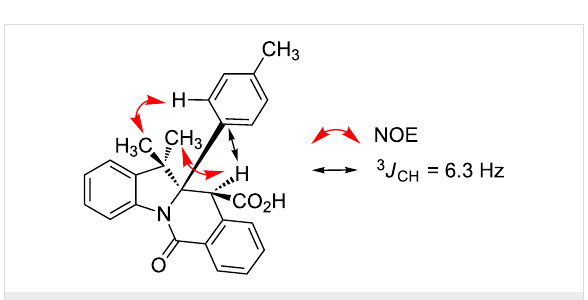
Figure 8: Criteria for stereochemistry assignment of anti - 10o